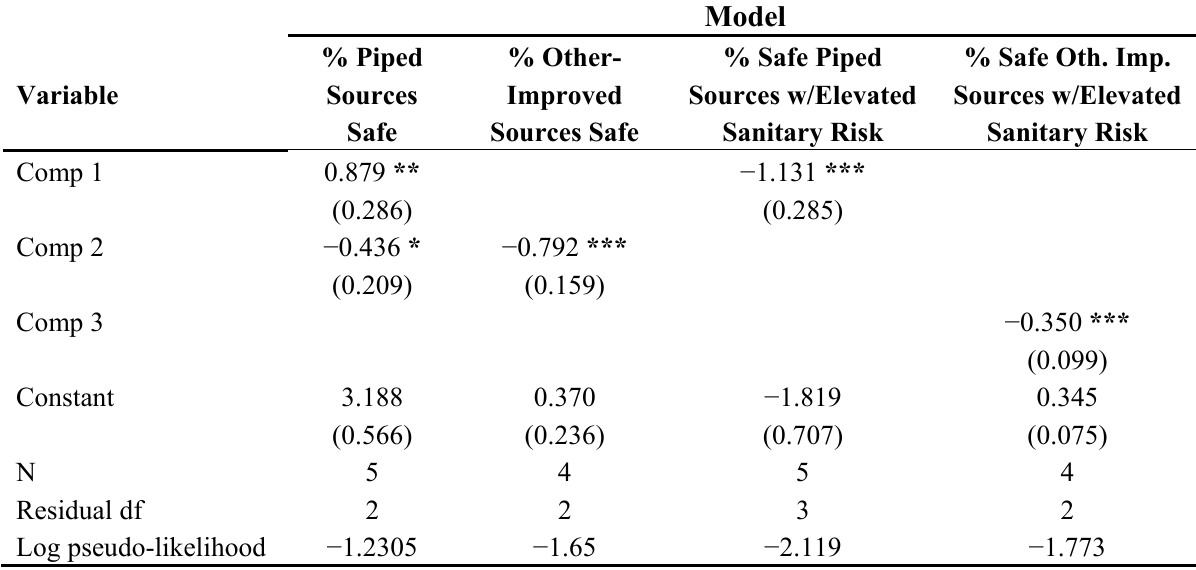
Table 6. Fractional Logit Models of Water Source Safety